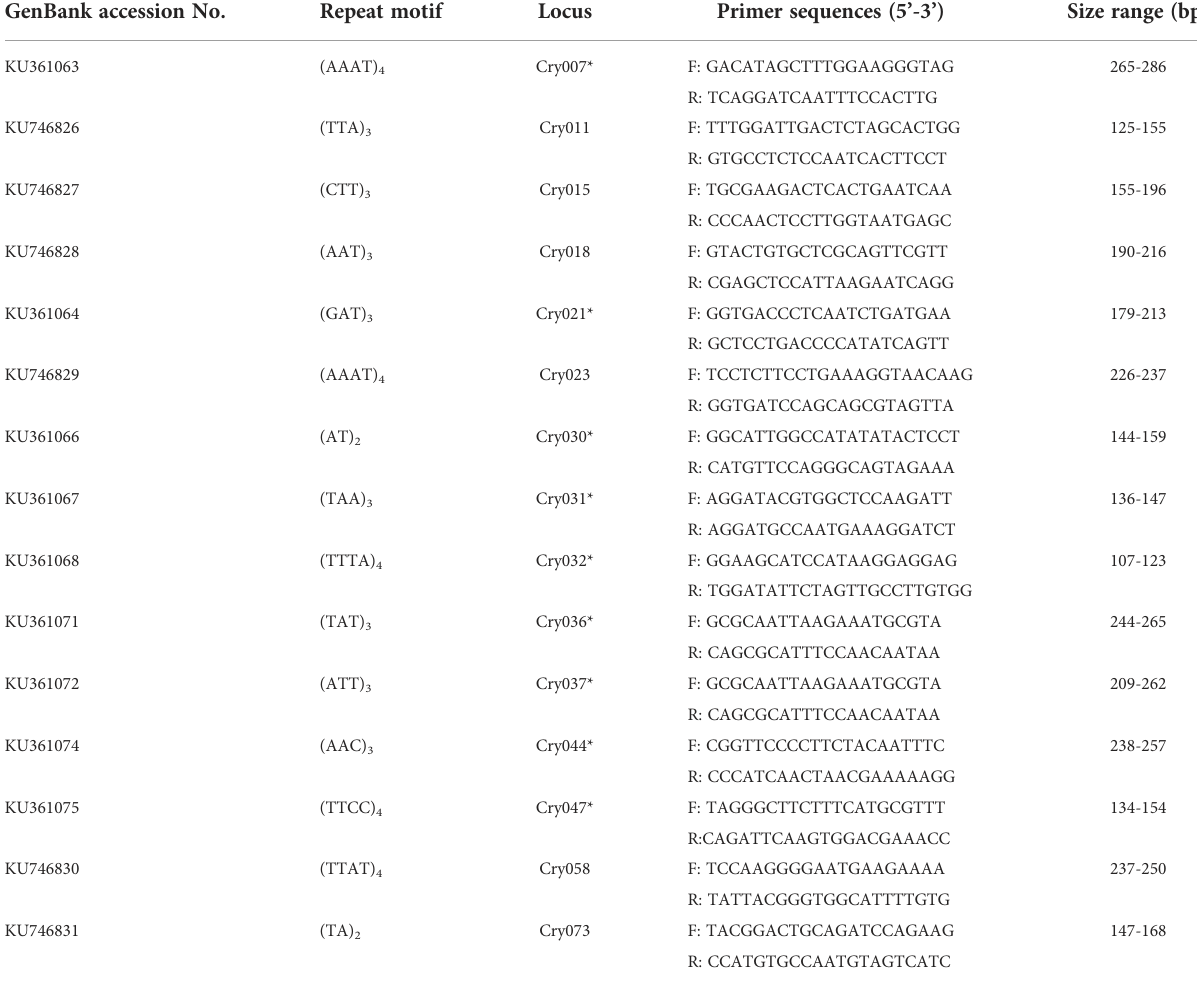
TABLE 1 Microsatellite loci used to analyze 179 Cryptolepis sanguinolenta samples collected from eight locations in Ghana. GenBank accession